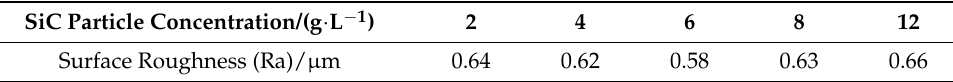
Table 6. Effect of SiC particle concentration on the surface roughness of